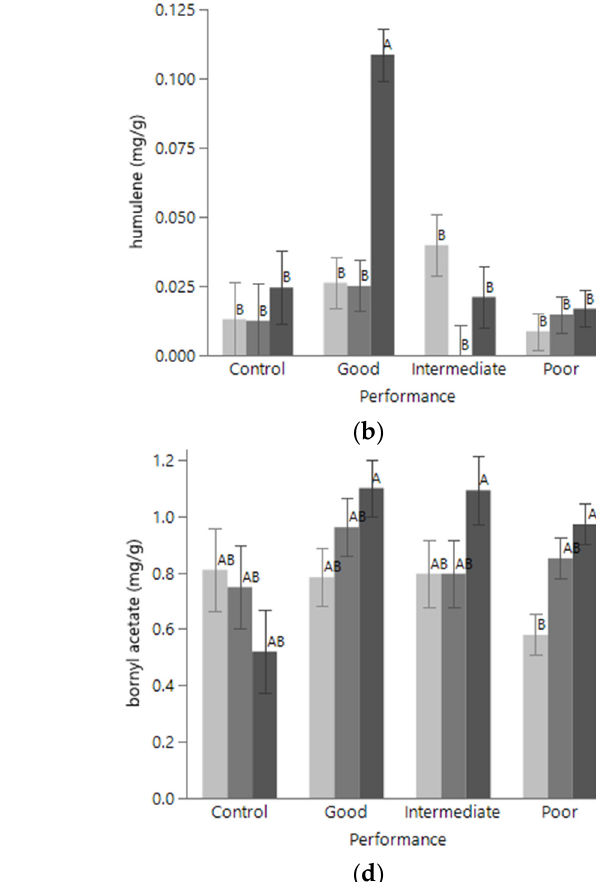
significantly different (Tukey’s HSD, α ≤